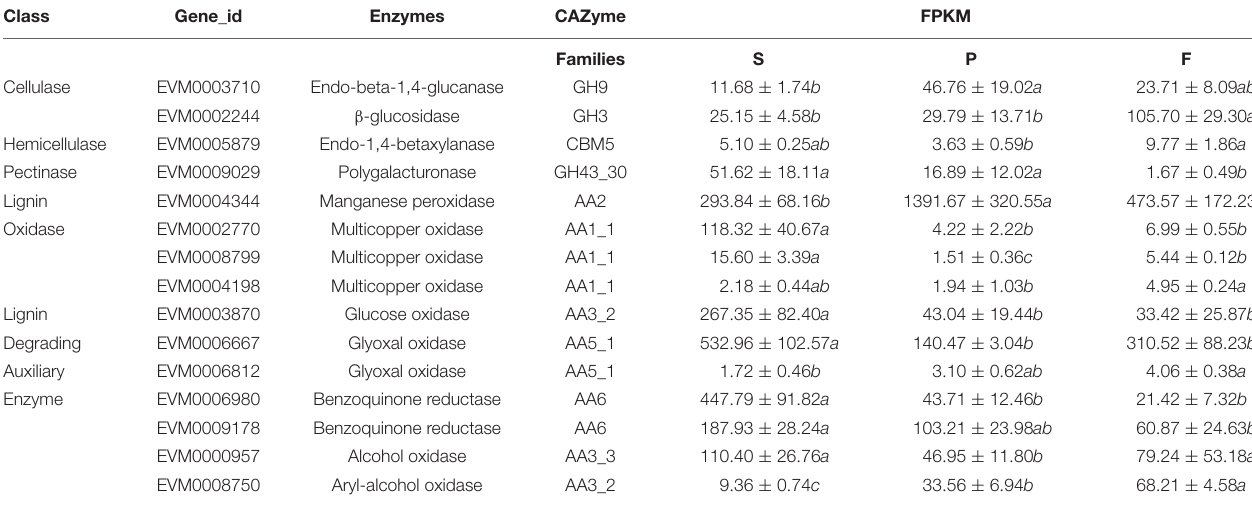
TABLE 4 | FPKM of DEGs annotated as lignocellulose degradation enzymes.